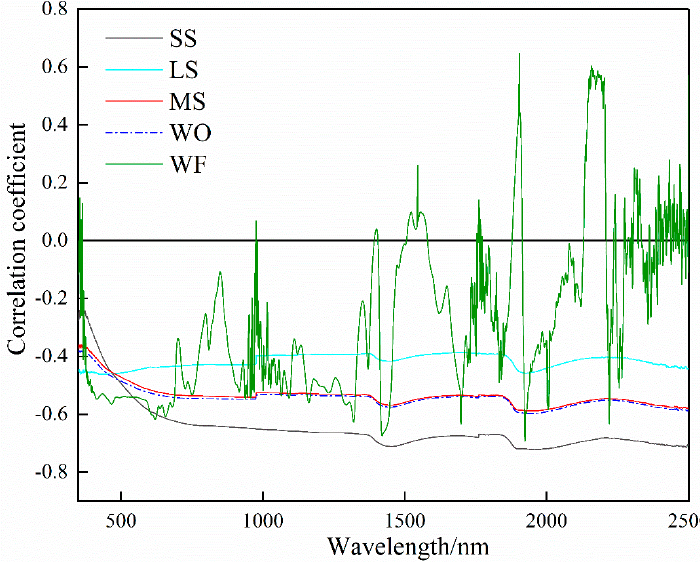
Figure 6. The Pearson correlation coefficient between spectra and SMC.